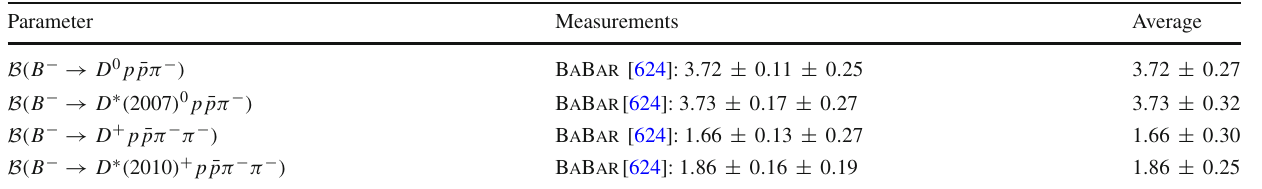
Table 147 Baryonic decays I [ 10 − 4 ] Parameter